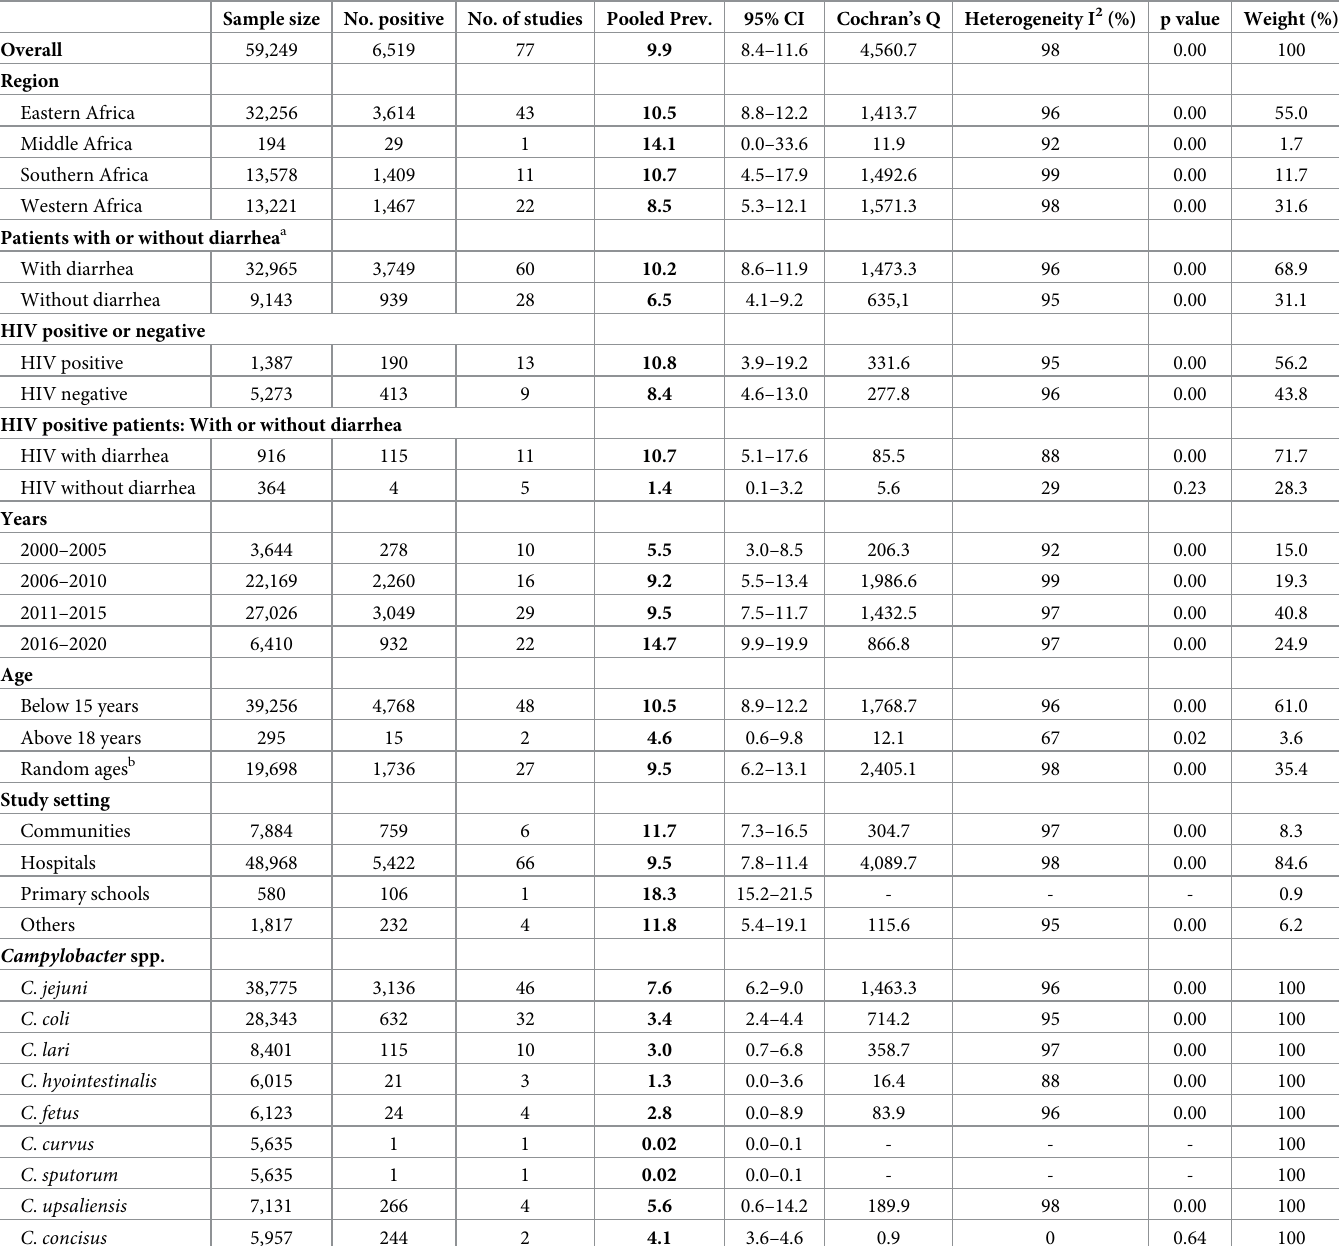
Table 2. Pooled prevalence of Campylobacter spp. stratified by subgroups. Sample size No. positive No. of studies Pooled